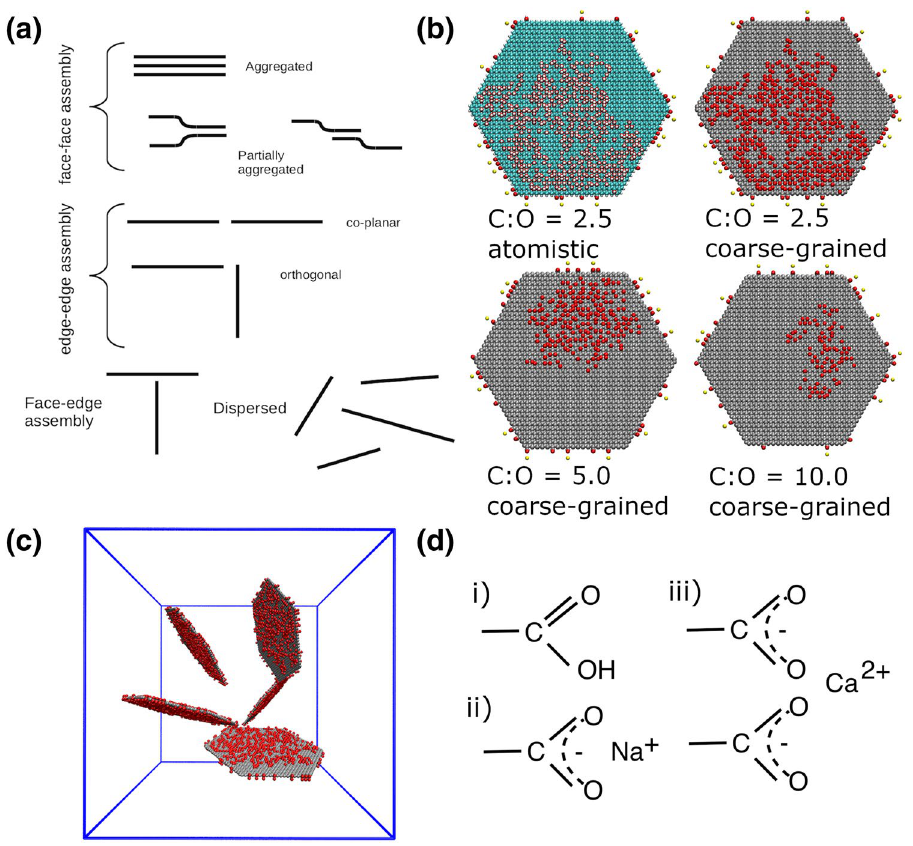
Figure 1. ( a ) Schematic diagram displaying the different morphologies and aggregation interaction modes formed by the graphene (oxide) flakes. The flakes at the top right ( b ) are examples of GO sheets oxidised to different extents. The first flake shows the GO flake with a C:O ratio of 2.5 at the atomistic level. In this example, the carboxylic edge groups are deprotonated with a calcium counterion. The colour scheme for atomistic systems is: carbon is cyan, oxygen is red, hydrogen is white, calcium is yellow and sodium is blue. The remaining flakes are shown at the coarse-grained level. The red circles represent the oxidised hydroxyl groups and edge carboxylic groups, and grey represents graphitic carbon atoms. The diameter of each flake is 10 nm. ( c ) shows the dispersed initial configuration (water not shown). There are five flakes within each simulation cell. The solid blue lines are the periodic boundaries, with lattice parameters of approximately 18nm. d) shows the different carboxylic edge groups considered in this study, (i) prontonated \ neutral (i.e low pH), (ii)